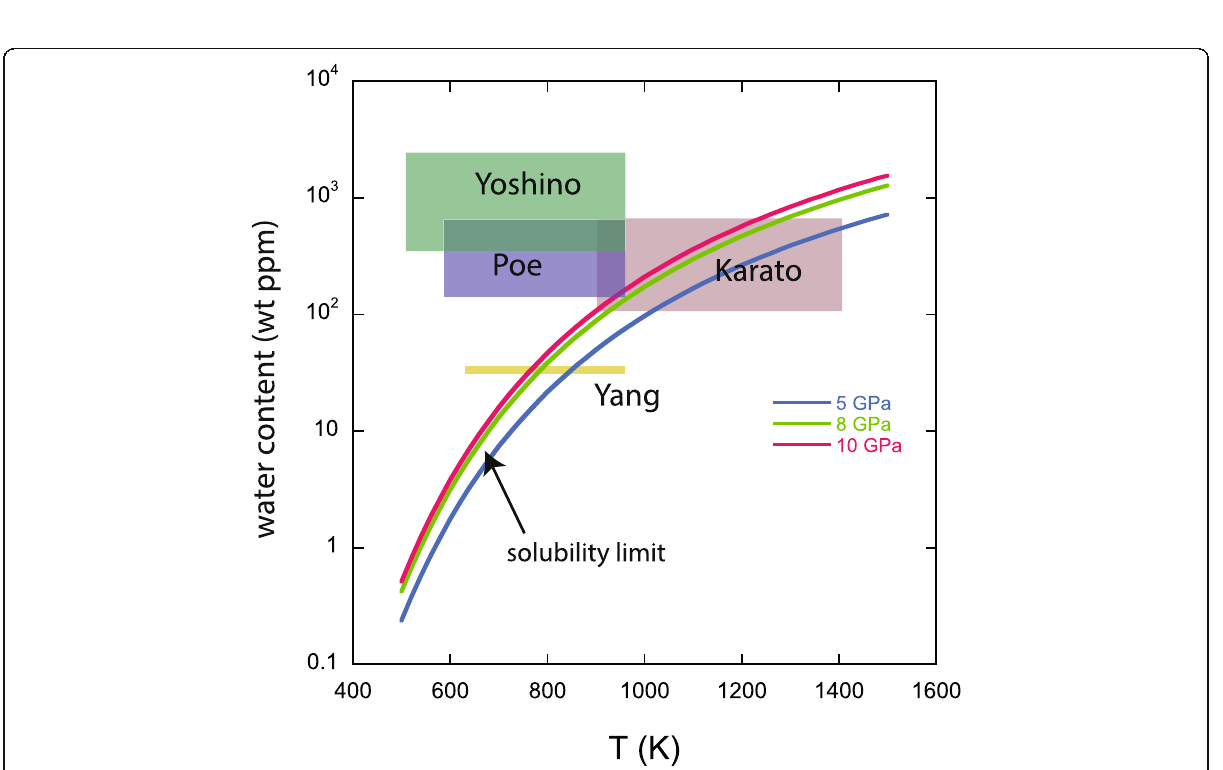
Fig. 6 A comparison of water content-temperature conditions of various studies with the solubility of water. Solubility of water in olivine depends strongly on temperature (Zhao et al. 2004). The experimental studies by Yoshino and Poe ’ s group were all conducted under the conditions where samples are highly super-saturated with water